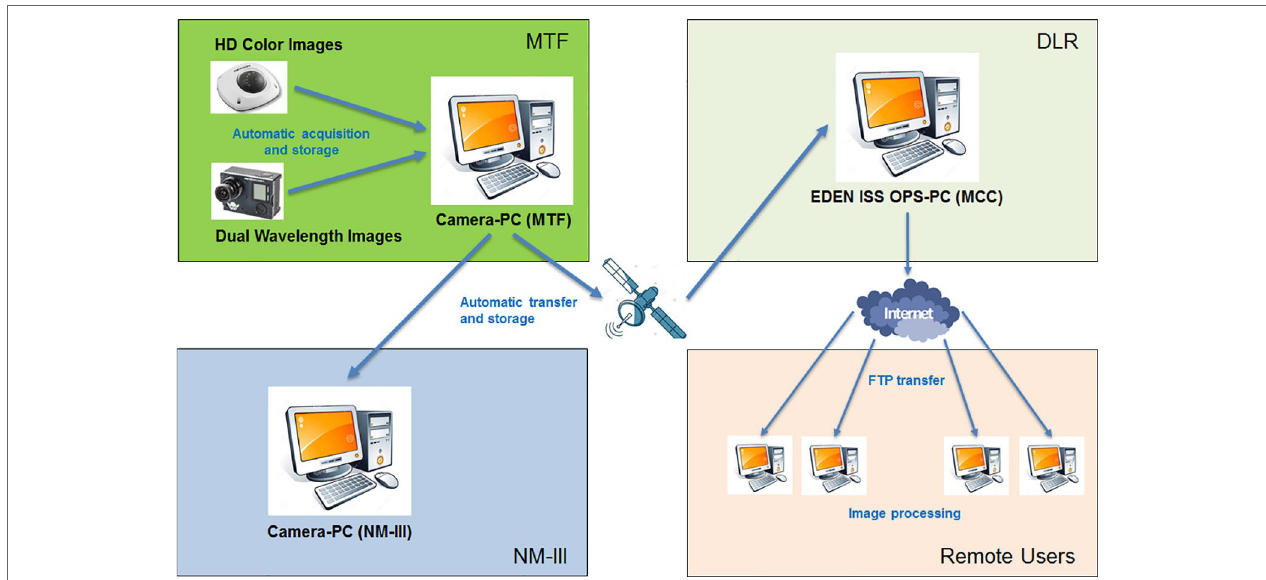
FIGUrE 3 | Pictorial schematic of the image acquisition and distribution process.